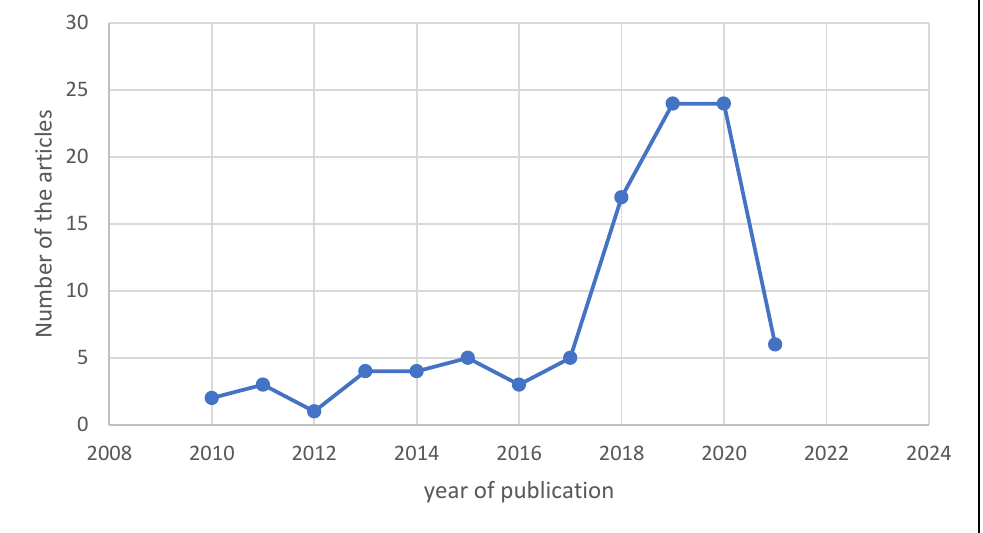
Figure 9. The number of papers with the corresponding years of publication.